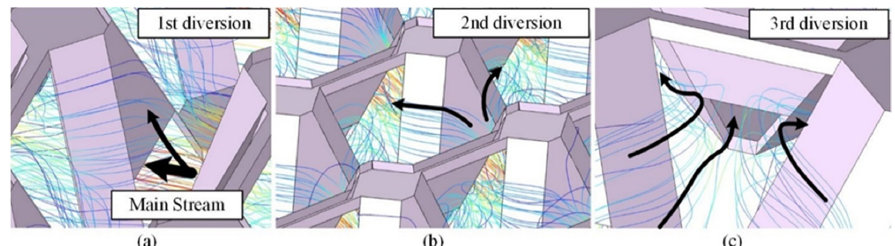
Figure 3. Three main states of the cathode reactant gas in an entire process flowing through a 3D bionic unit: ( a ) the first diversion, ( b ) the second diversion, ( c ) the third diversion.